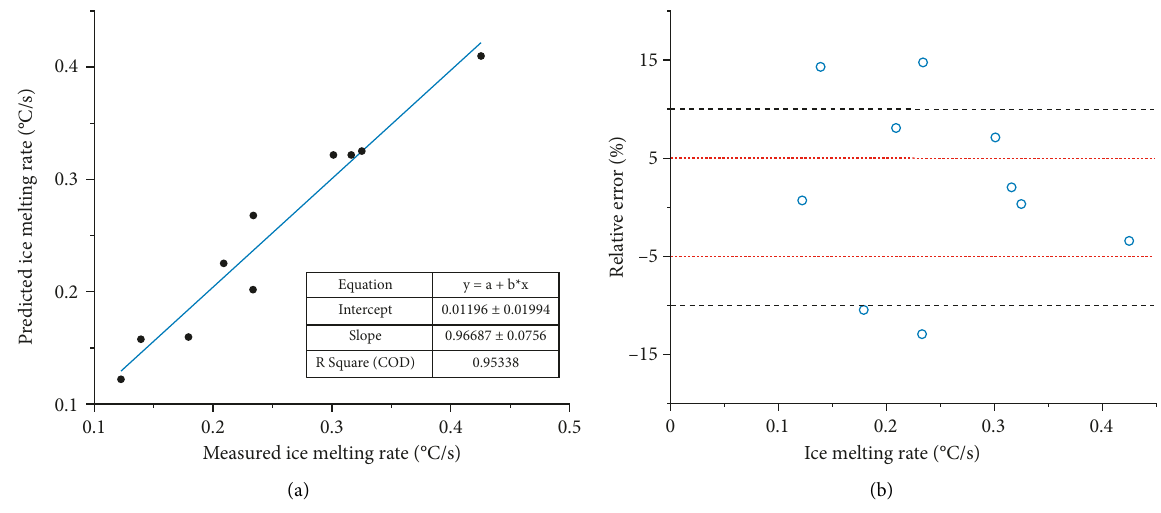
Figure 13: Fitting effects of double-hidden layer BP model. (a) Fitting curve. (b) Fitting